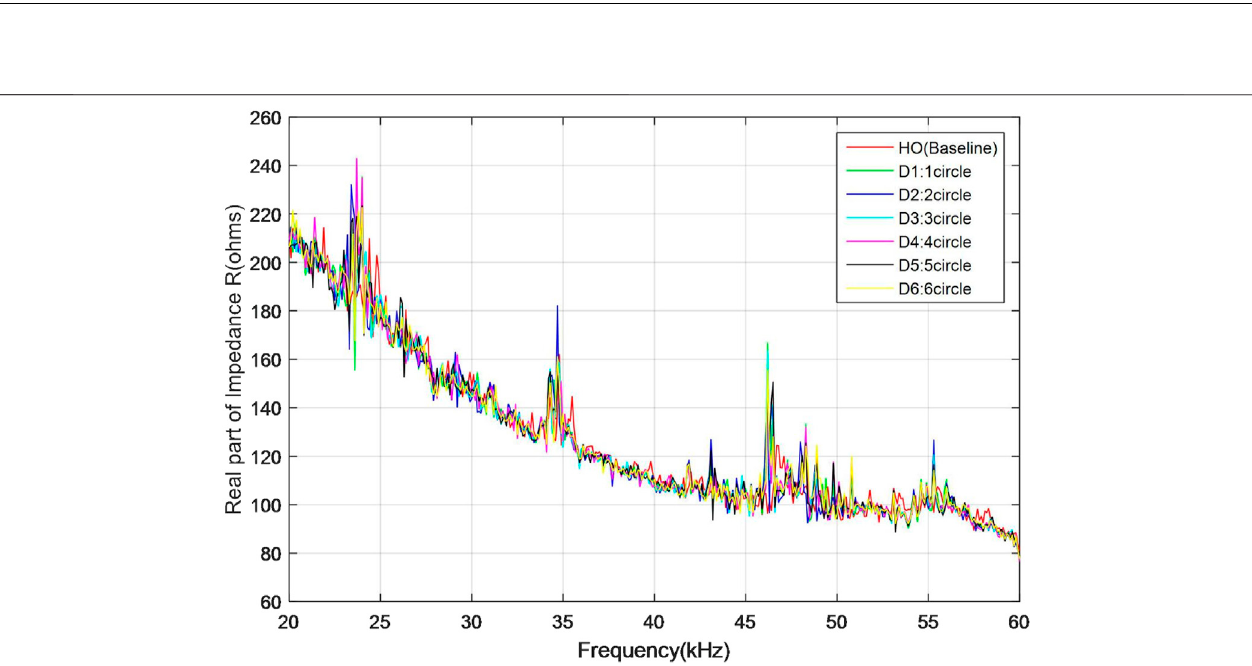
FIGURE 6 | Measured electrical impedance signatures of the PZT patch by